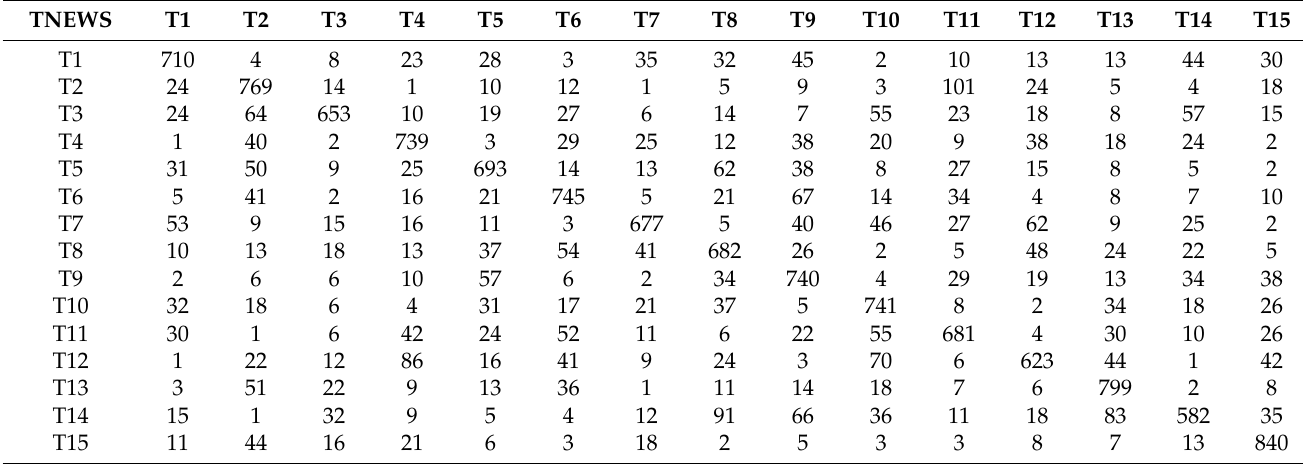
Table A5. Model performance. Confusion metric on